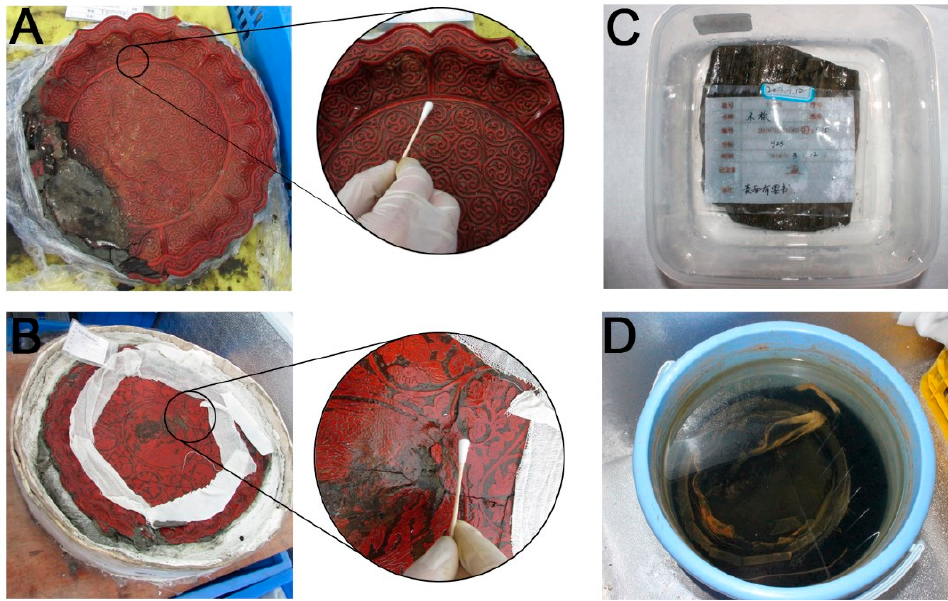
Figure 1. Sampling areas for microbiological analyses on the wood lacquers surfaces: ( A ) lacquer NHI566; ( B ) lacquer NHI883; ( C ) water sample NHI935; ( D ) water sample NHI58.